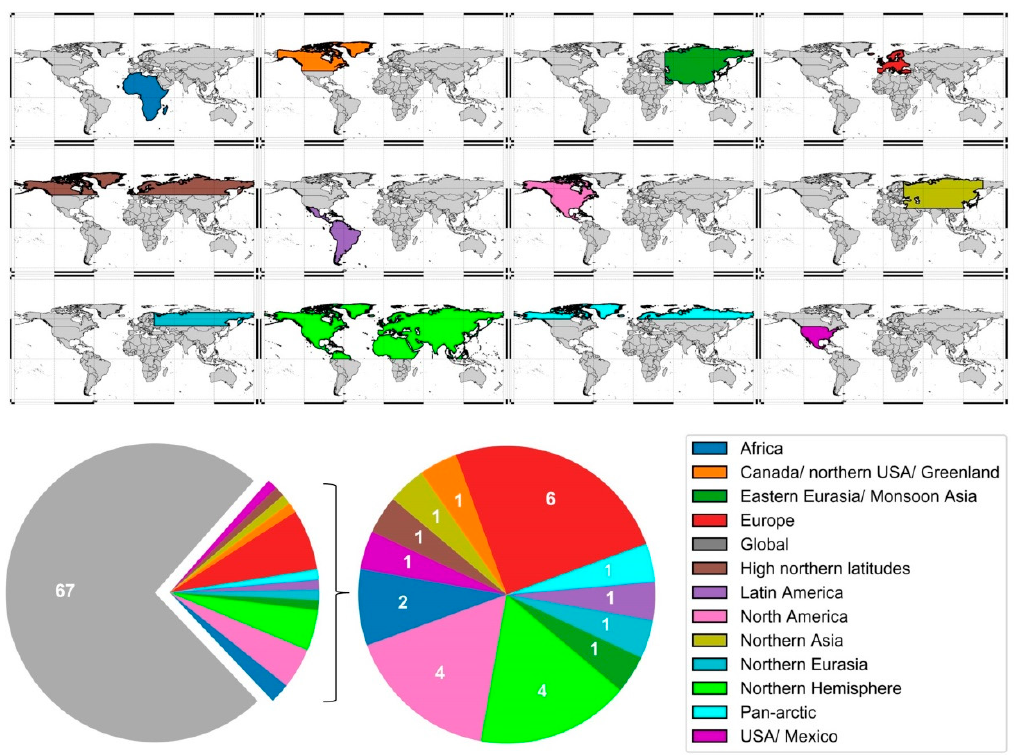
Figure 9. The number of reviewed studies in specific regions of interest.